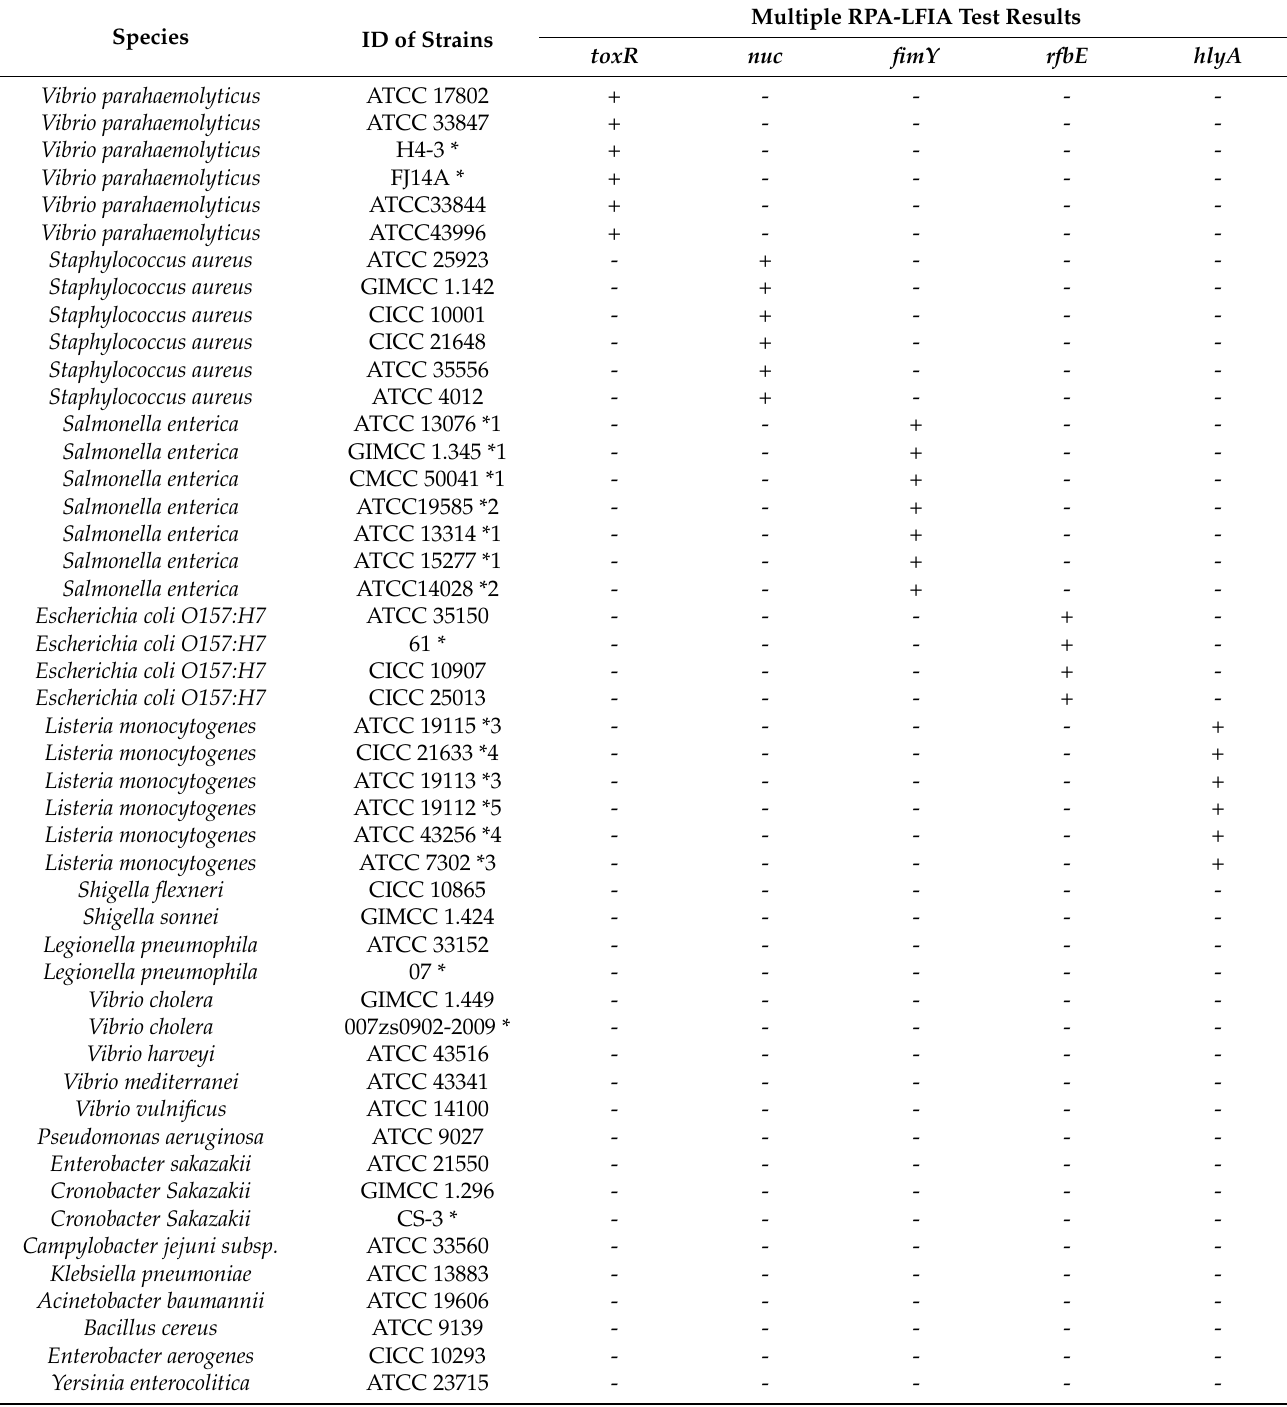
Table 1. Information of bacterial strains used for specificity